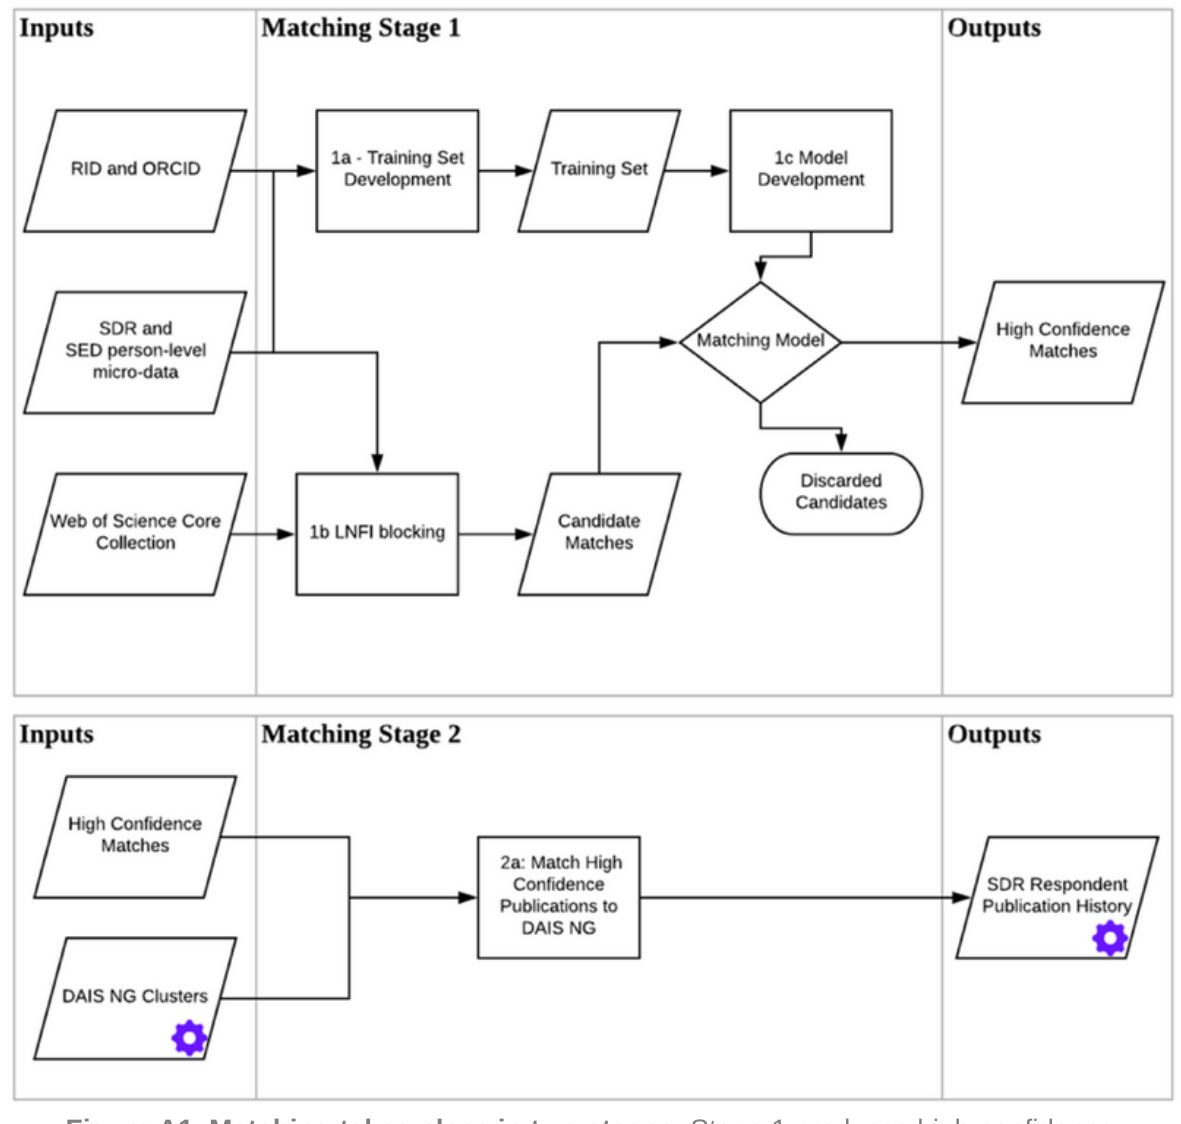
Figure A1. Matching takes place in two stages. Stage 1 produces high-confidence matches for the Survey of Doctorate Recipients (SDR) respondents and Stage 2 expands the matching process by utilizing WoS Author Clusters (DAIS NG). The gold standard data, manually curated publication histories developed for two sets of SDR respondents each, 800 REFID and 785 REFID, were used in two places during this process as indicated by the purple gear icons: (1) a training set and (2) a test set used to conduct postprocessing targeting 95% Precision during Stage 1 and to produce a final assessment of precision and recall after Stage 2. LNFI = Last name plus First initial; REFID is the SDR person identifier; SED = Survey of Earned